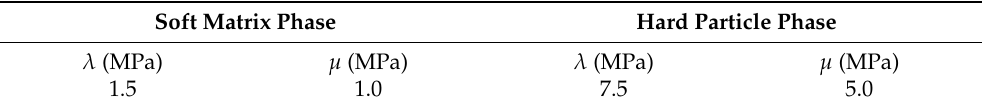
Figure 5. Representative volume element structure of the studied particle reinforced composite. The structure is represented in 31 × 31 × 31 voxels, 1333 of which are occupied by the reinforced phase and are distributed randomly and uniformly. Two phases of the structure are characterized by the local model. The macroscopic stress–strain data are calculated with the displacement-based-FFT (DBFFT) method. An artificial neural network (ANN) and a tensorial sparse symbolic regression (TSSR) model are trained with the data. Table 2. Coefficients of the constitutive model for the matrix and particles of the simulated particle reinforced